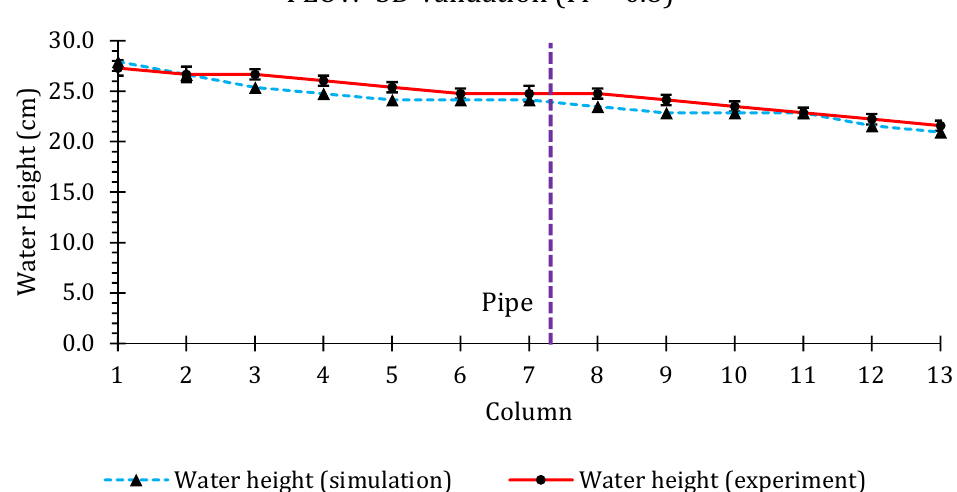
Figure 23. Water heights in the flume and based on FLOW-3D results, for Fr = 0.8.